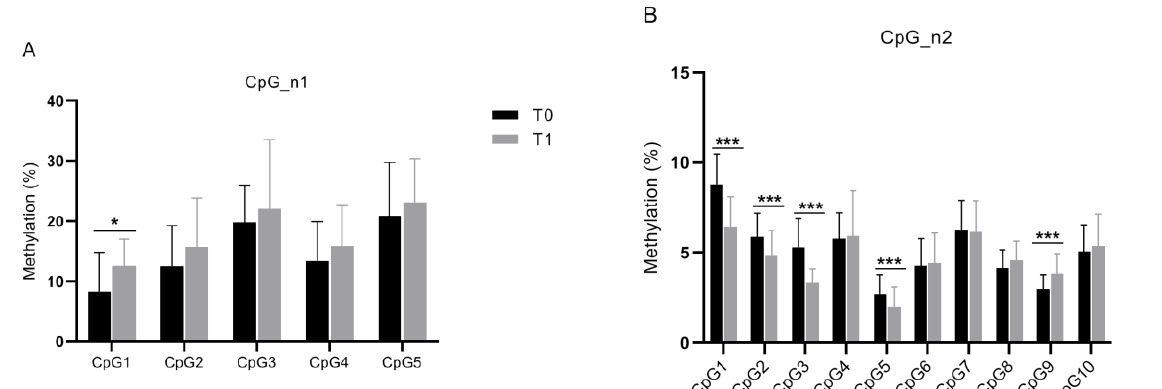
Figure 2. Histogram of SLC6A4 average methylation percentage. ( A ) Methylation degree of five CpG sites within CpG_n1 island analyzed in 36 patients with stroke at baseline (T0) and after the 30-session rehabilitation treatment (T1). ( B ) Methylation degree of ten CpG sites within CpG_n2 island analyzed in 36 patients with stroke at baseline (T0) and after the 30-session rehabilitation treatment (T1). The asterisks indicate a statistically significant differences: *** p < 0.001 and * p < 0.005, according to the paired t